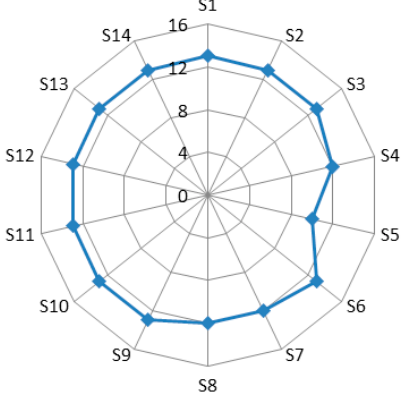
Figure 3. In/out-degree for the one-mode stakeholder social network.